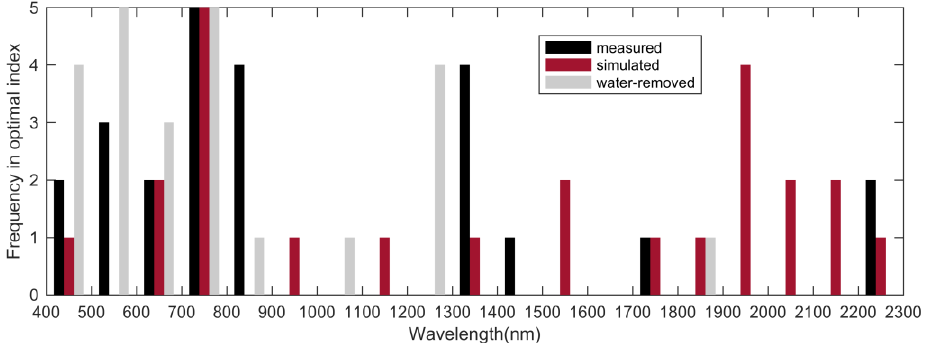
Figure 4. Histogram of the wavelength frequency in the species-specific optimal spectral indices.